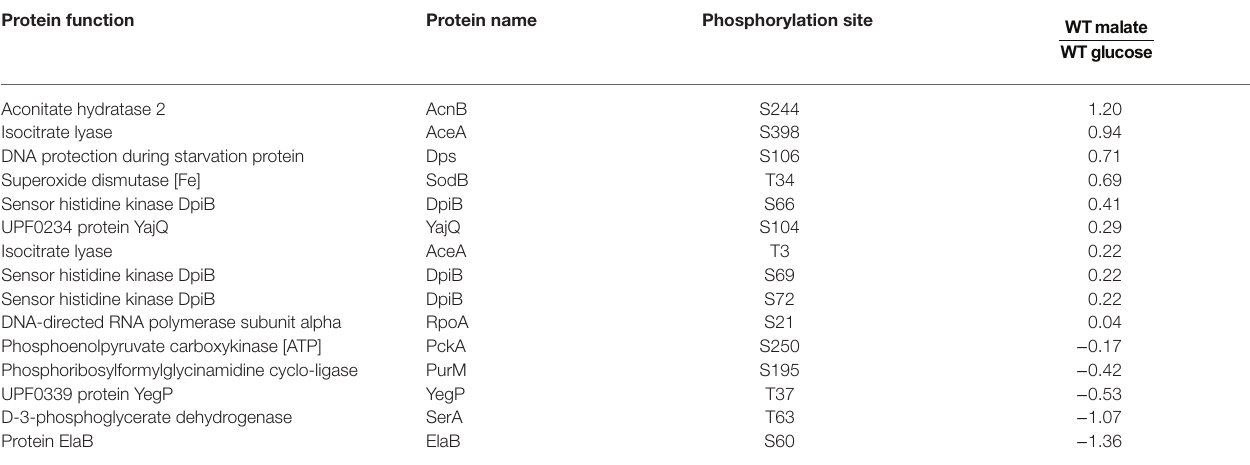
TABLE 3 | List of proteins identified as phosphorylated in both conditions in the wild type strain but not in the Δ yeaG